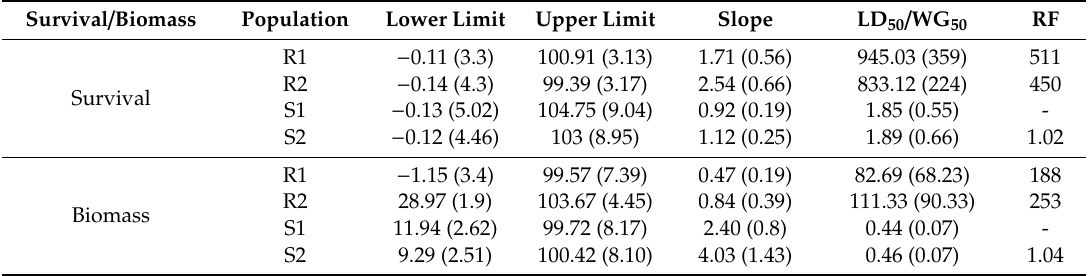
Table 3. Estimated log-logistic regression parameters for resistant (R) and susceptible (S) Rapistrum rugosum populations to tribenuron-methyl.